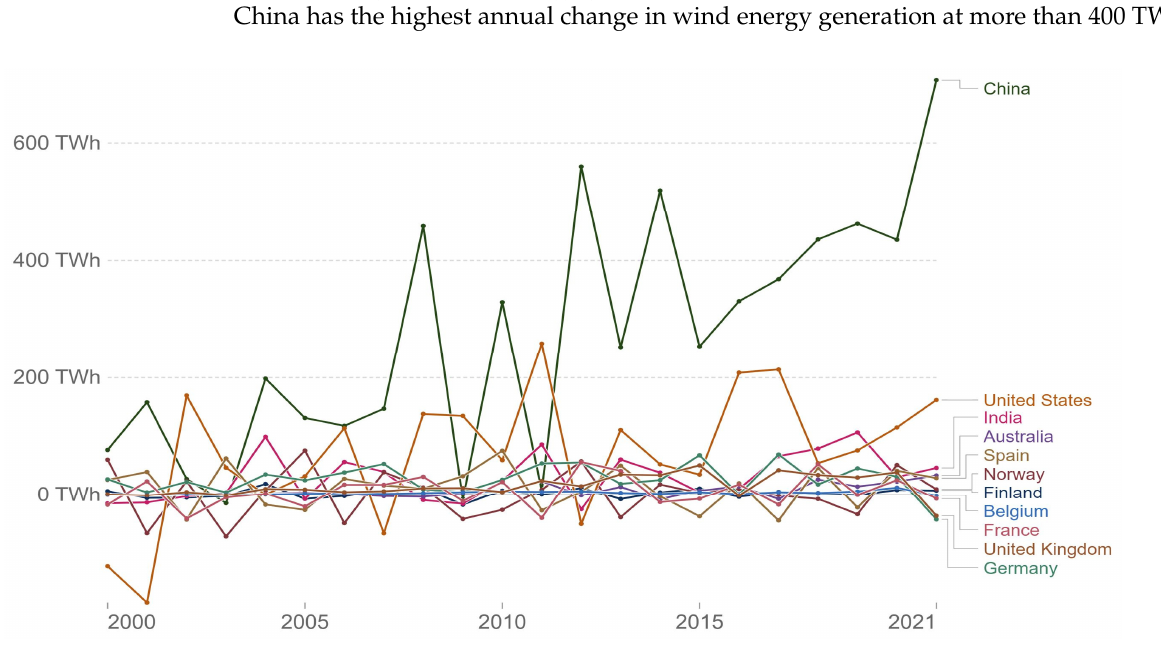
Figure 6. Global distribution of EV per charging point for 2021 [40].